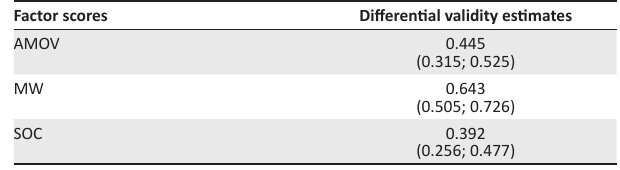
TABLE 6: Stage-3 results: External validity assessment (Part